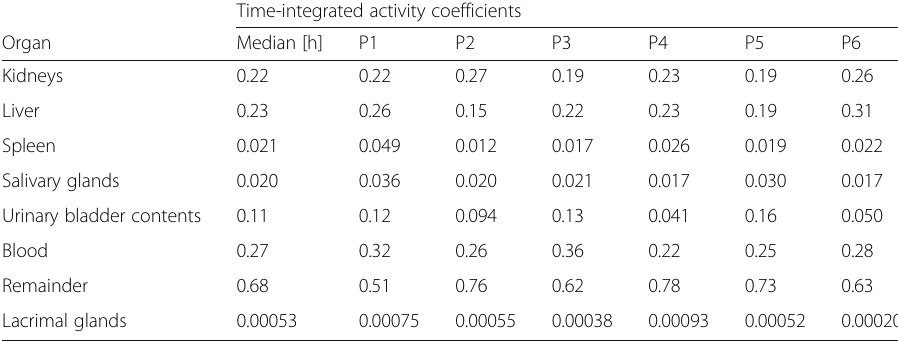
Table 1 Median and individual time-integrated activity coefficients of an injection with [ 68 Ga]PSMA-11. The individual TIACs are calculated using the organ masses of the ICRP/ICRU voxel